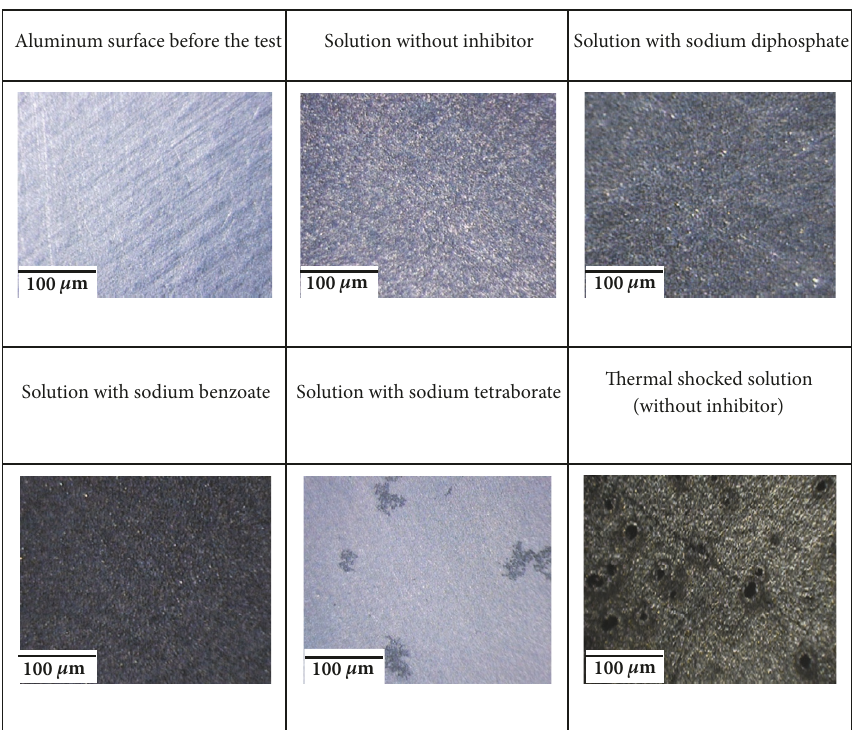
Figure 3: Optical micrographs of the aluminum alloy surfaces before and after the potentiodynamic polarization tests.